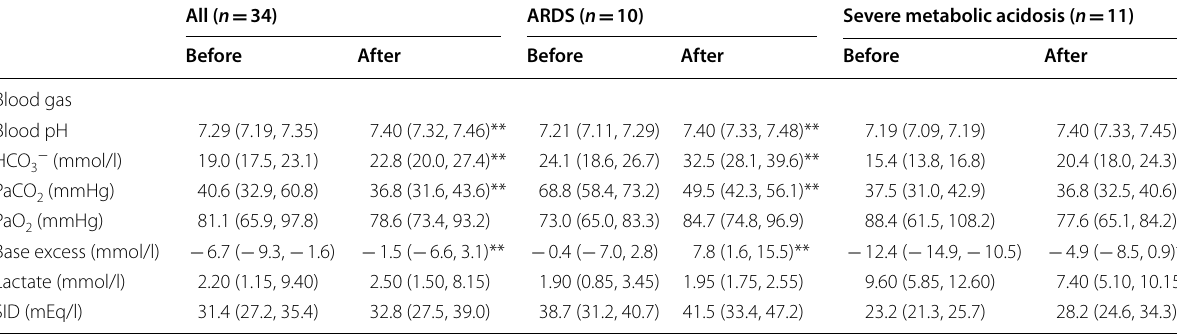
Apart from the summary of all treatment sessions, Table 3 illustrates the blood gas parameters of two subgroups (i.e., patients with ARDS and patients with severe metabolic acidosis immediately prior to ADVOS. Median (IQ25, IQ75). Non-parametric paired Wilcoxon test. * p < 0.05, ** p < 0.01